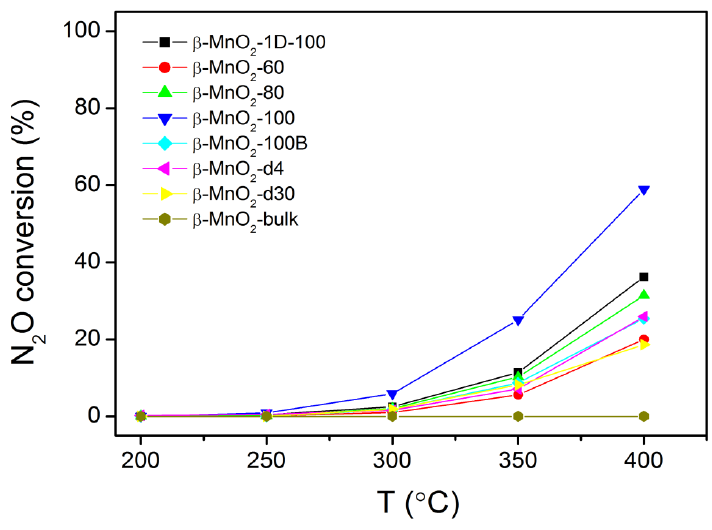
Figure 5. N O conversions of mesoporous β -MnO 2 concentration: 0.5% (in He); flow rate: 60